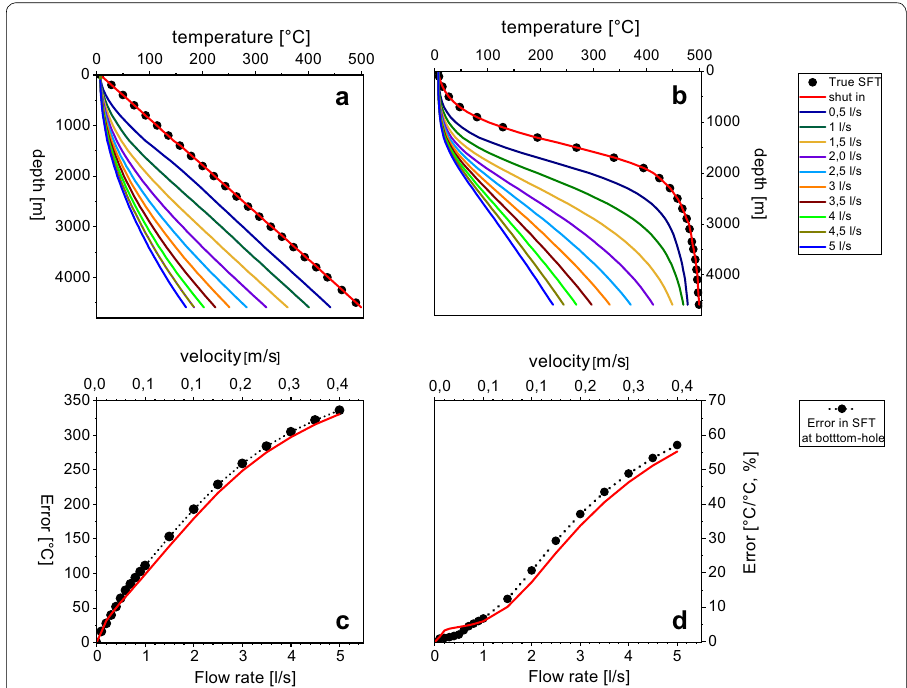
Fig. 5 Estimated SFT profile under different flow rates ( Q ) in the annulus during the second period versus depth when assuming a a linear SFT profile and b S-shaped SFT profile (black dots represent the true SFTs, red lines represent the SFT estimates under real shut-in conditions). c Errors in SFT estimates for the linear-shaped SFT profile case. d Errors in SFT estimates for the S-shaped SFT profile